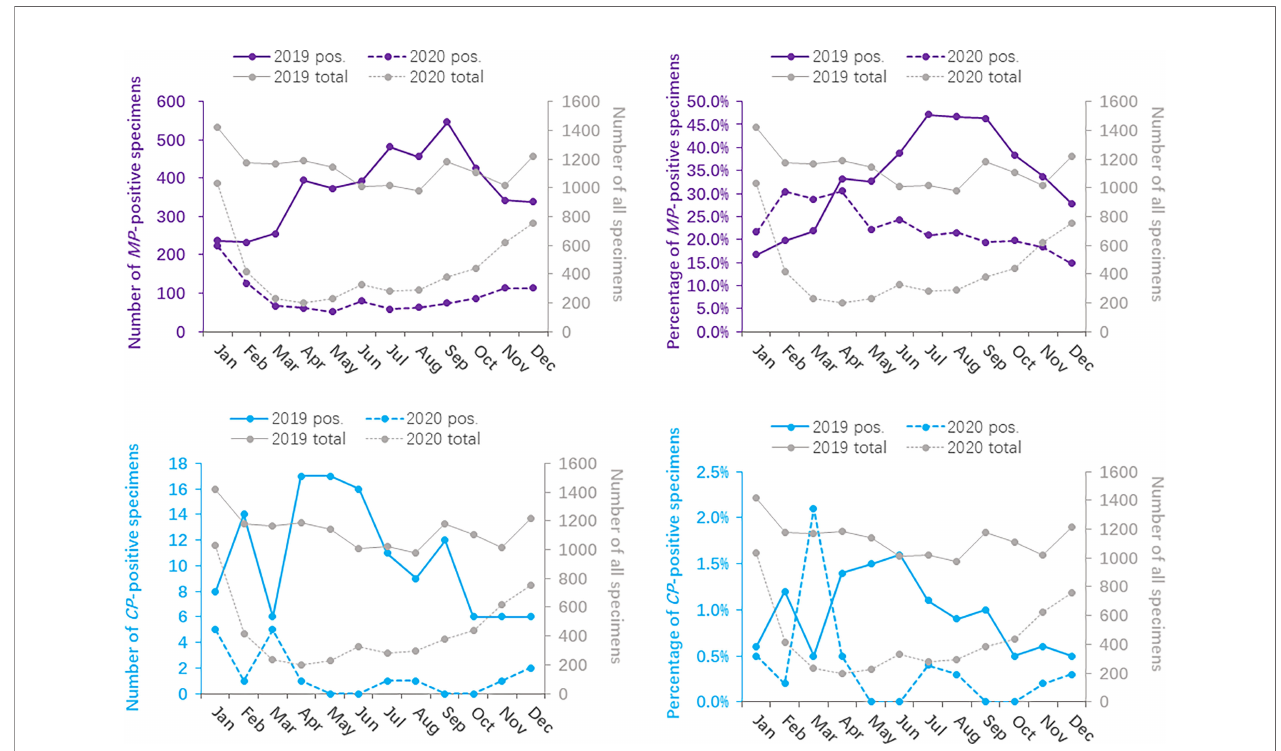
FIGURE 1 | Distribution of Mycoplasma pneumoniae- and Chlamydia pneumoniae -positive specimens based on age between 2020 (during the COVID-19 pandemic) and 2019 (before the COVID-19